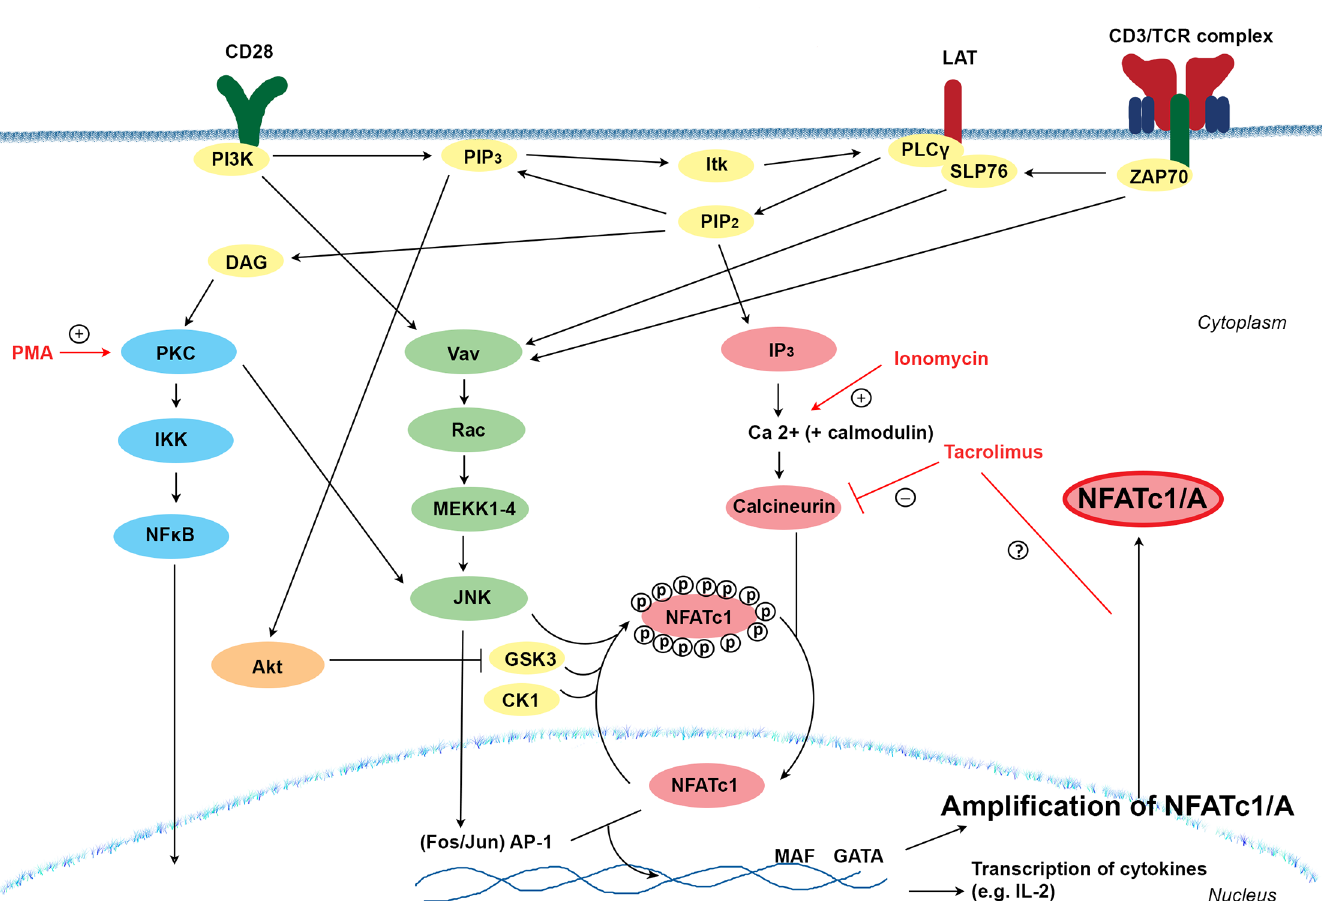
Fig 1. Schematic overview of the intracellular calcineurin pathway in T cells and amplification of the NFATc1/A isoform [11]. The calcineurin pathway is activated upon antigenic stimulation of the CD3/TCR complex in combination with co-stimulatory signals. This in turn activates the signal molecules phospholipase C- γ (PLC- γ ) and inositol 1,4,5-trisphosphate (IP 3 ) causing an influx of calcium and the opening of calcium channels in the membrane to maintain intracellular calcium levels. Upon interaction between calcium and the small calcium-binding protein, calmodulin, the phosphatase calcineurin is activated, which dephosphorylates NFAT. There are 13 phosphorylation sites present on NFAT that are known to be dephosphorylated upon activation. Dephosphorylation causes the translocation of NFAT to the nucleus where it will initiate gene transcription through the interaction with other transcription factors, such as AP-1. The signaling pathway is regulated by other signaling pathways, such as the MAPK pathway (JNK) and NF κ B pathway. Once in the nucleus, NFAT will act as transcription factor and regulates the production of cytokines and the amplification of the isoform NFATc1/A in a positive autoregulatory feedback loop. The intracellular signaling pathways can also be activated by using PMA/ ionomycin as a stimulus, while calcineurin inhibitors, such as TAC, are known to inhibit the calcineurin